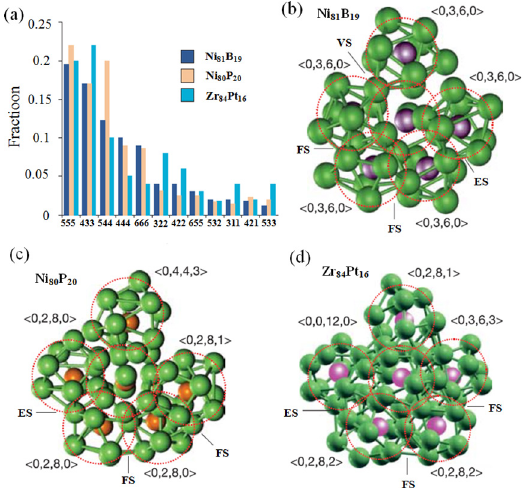
Figure 8. (a) The icosahedral type ordering of cluster in metallic glasses; (b) (c) and (d) The five-fold symmetry of cluster connections for Ni B , Ni P and Zr Pt , respectively. 81 19 80 20 84 16